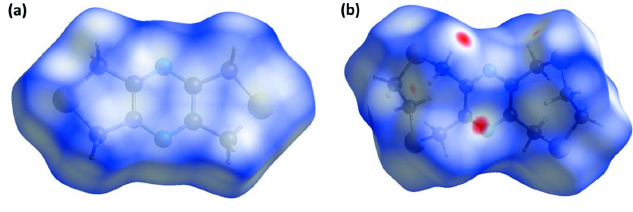
Figure 13 The full two-dimensional fingerprint plot for L2 , and fingerprint plots delineated into H (cid:2)(cid:2)(cid:2) H, S (cid:2)(cid:2)(cid:2) H/H (cid:2)(cid:2)(cid:2) S, N (cid:2)(cid:2)(cid:2) H/H (cid:2)(cid:2)(cid:2) N, C (cid:2)(cid:2)(cid:2) H/H (cid:2)(cid:2)(cid:2) C, and S (cid:2)(cid:2)(cid:2) S contacts.